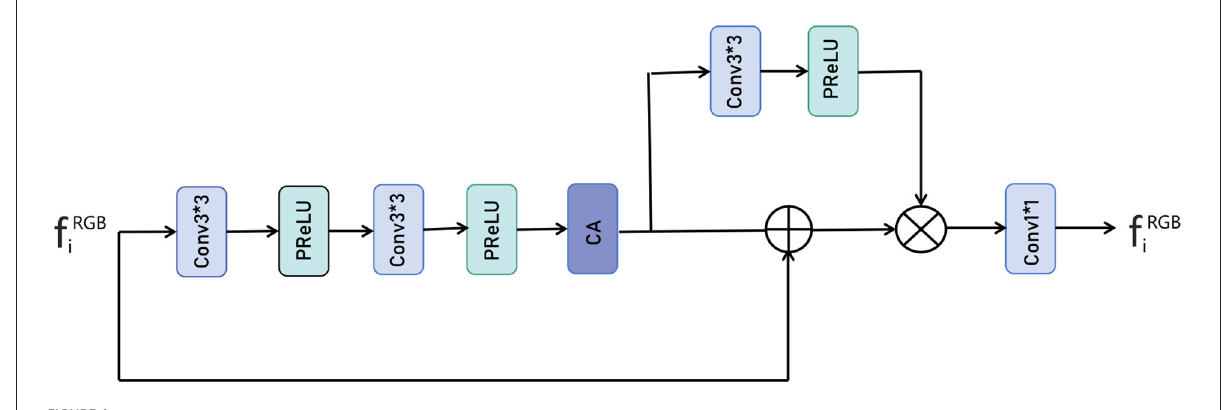
FIGURE4 The proposed Feature Refinement (FR)